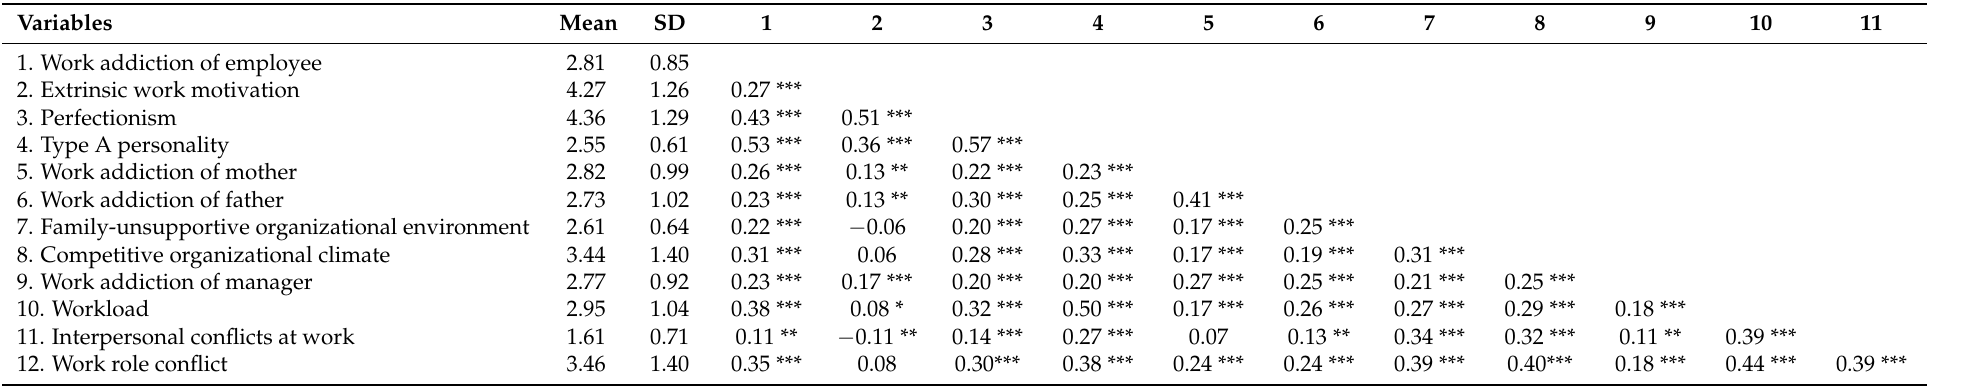
Table 2. Correlations, means, and standard deviations of the study